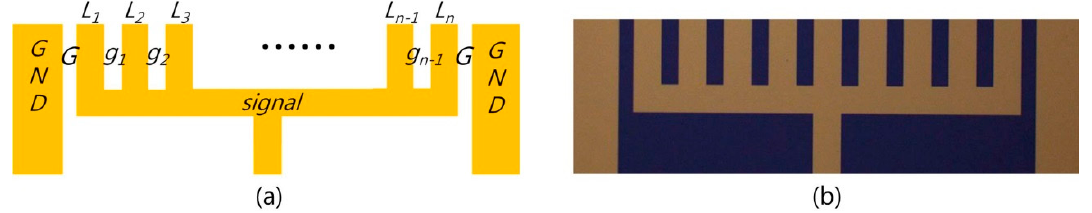
Figure 1. Multiline coplanar waveguide structure: ( a ) basic structure, and ( b ) fabricated example ( n = 9, L = 100 μ m, g = 60 μ m, and G = 52 μ m).